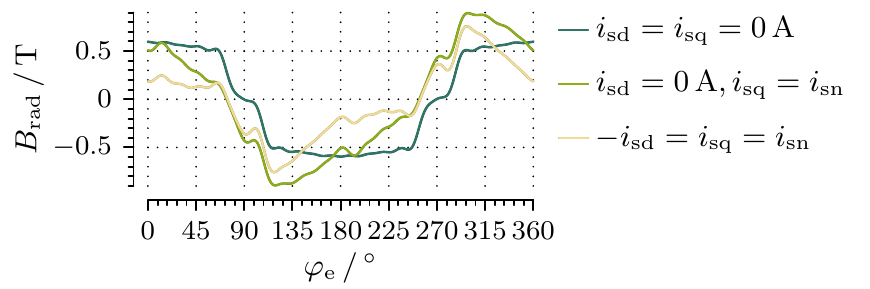
Figure 4. Variations in B rad observed by θ m = 0 ◦ at ¯ r sl during a single electrical rotation of the rotor at different load points.